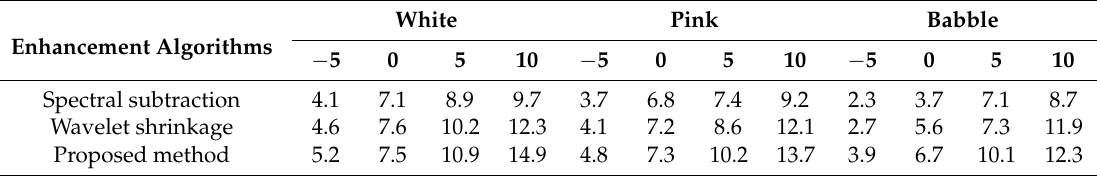
Table 2. Comparison of the SNRs obtained by using three enhancement algorithms. White Enhancement Algorithms